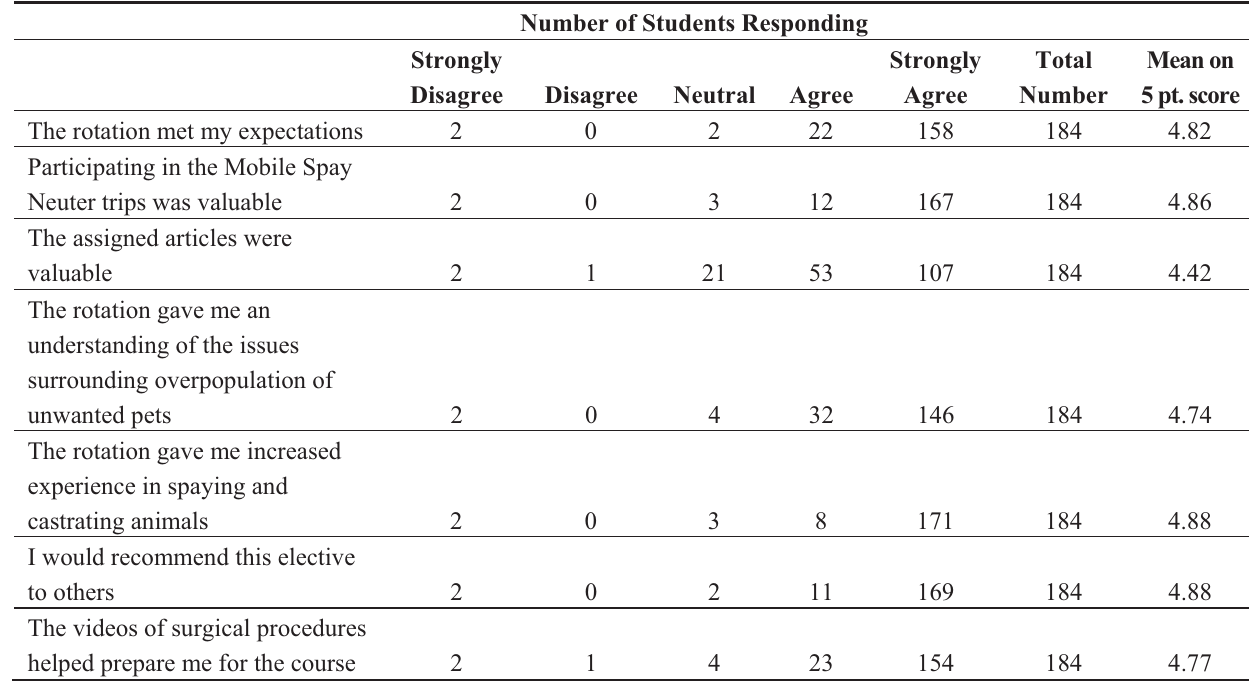
Table 4. Student evaluations of the shelter elective since acquisition of the second mobile unit.